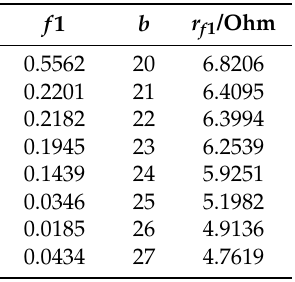
Table 12. Optimal solutions of f 1 when fault occurred at each node in set 1 for Case 5.